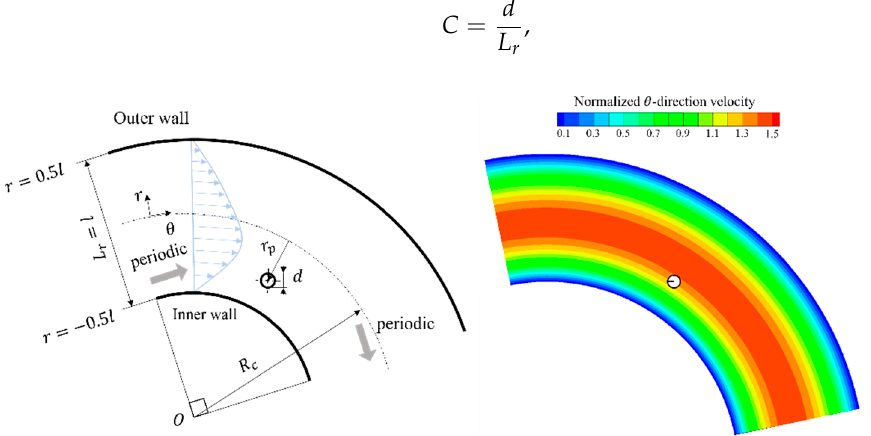
Figure 1. Schematic view of curvilinear channel